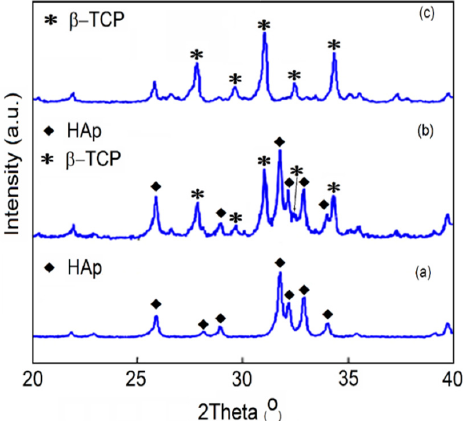
Figure 3. Time averaged attenuation for the 1000 samples in the selected frequency range.